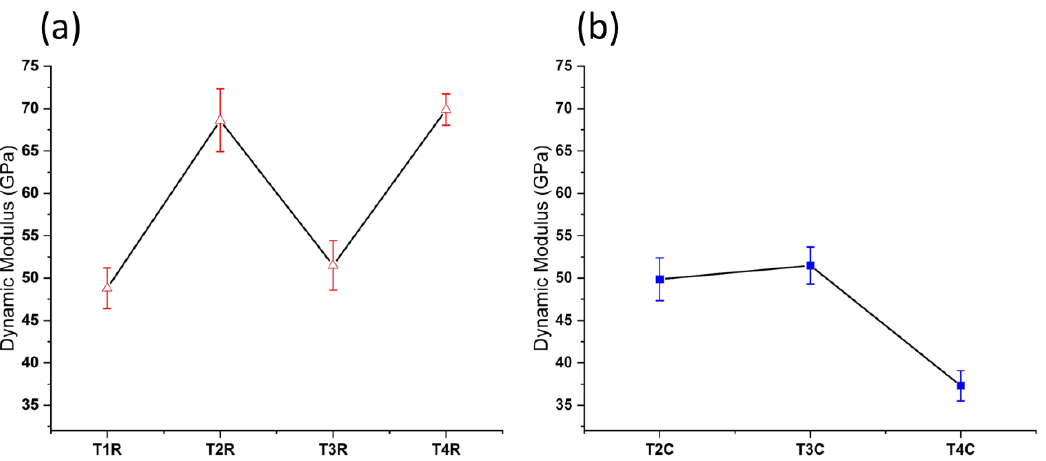
Figure 3. Dynamic modulus behavior under different temperatures. ( a ) Specimens without coating under room temperature, 140, 200, and 290 °C. ( b ) Effect of ceramic coating on the dynamic modulus.